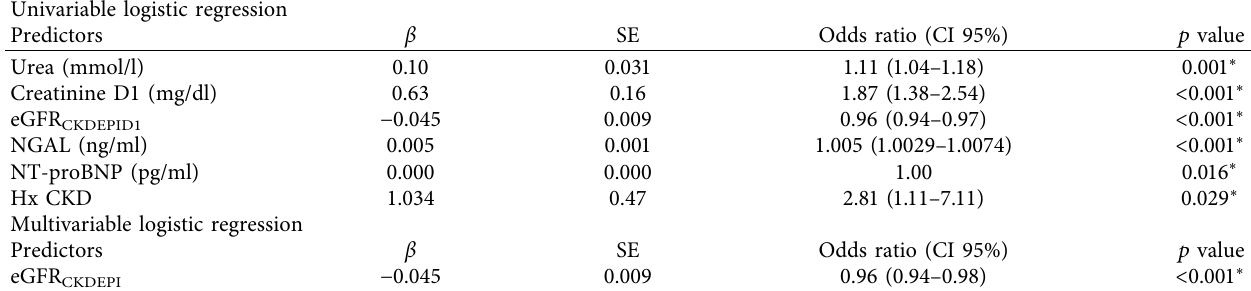
Table 4: Univariable and multivariable logistic regression between CRS1 and some variables.